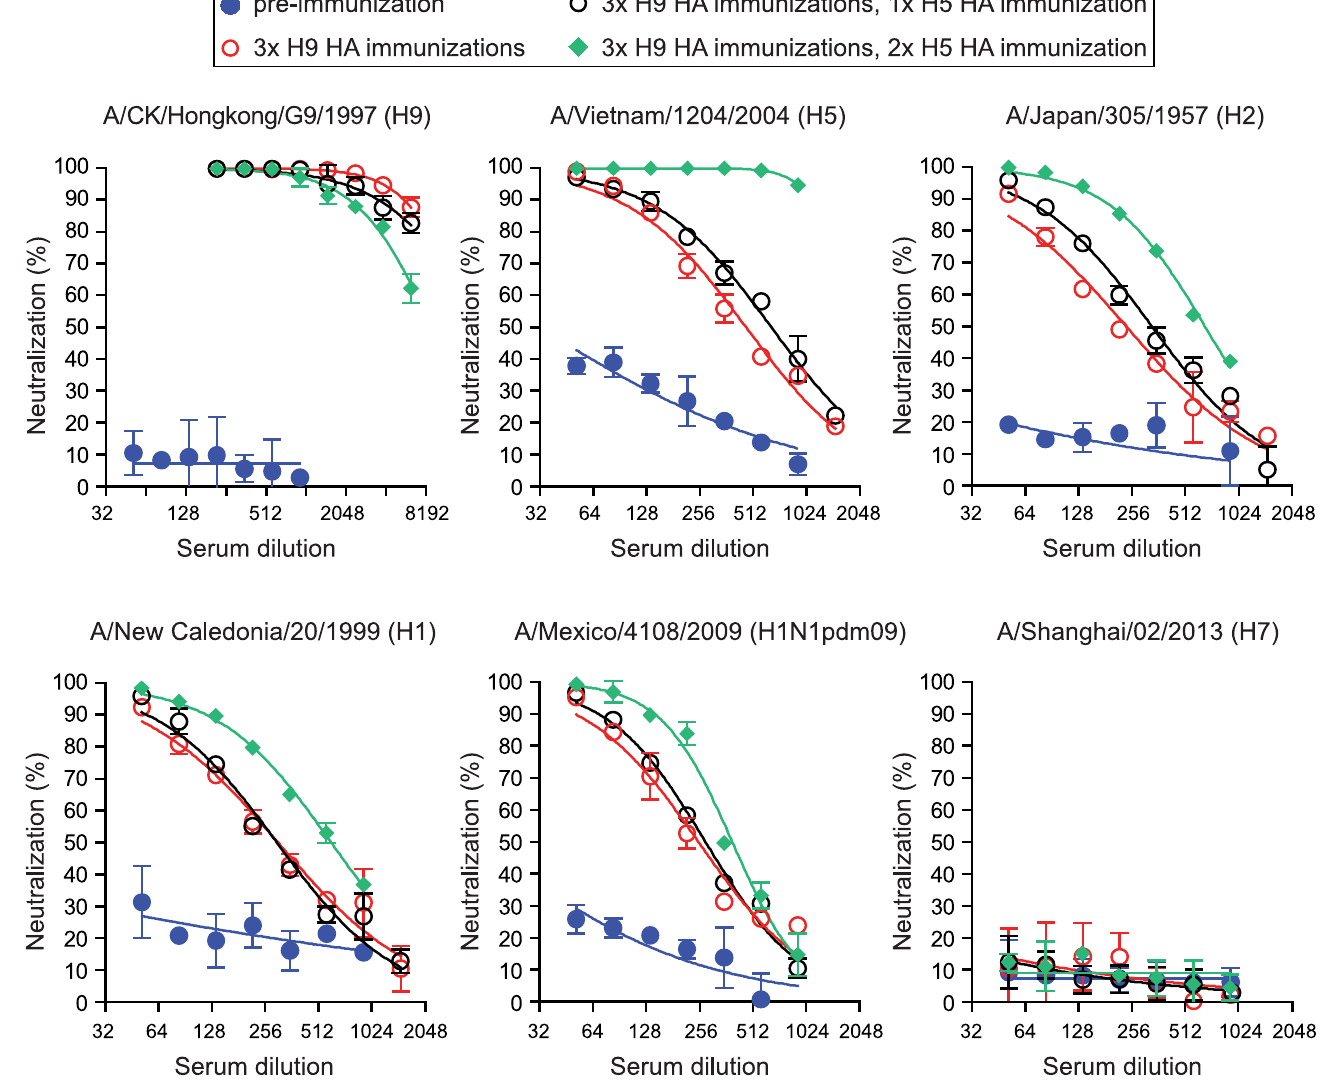
Fig 1. Heterosubtypic HA immunizations elicit cross-neutralizing antibodies. Neutralization ability against A/chicken/Hong Kong/G9/1997 (H9), A/Vietnam/ 1203/2004 (H5), A/Japan/305/1957 (H2), A/New Caledonia/20/1999 (H1), A/Mexico/4108/2009 (H1N1pdm09) and A/Netherland/219/2003 (H7) HA- pseudoviruses in one rabbit sera collected pre- and post- immunizations as indicated. Data are shown as means and standard deviations. Blue circle: pre- immunization; Red open circle: post 3 immunizations of H9 HA; Black open circle: post 3 immunizations of H9 HA and one immunization of H5 HA; Green diamond: post 3 immunizations of H9 HA and two immunizations of H5 HA. Similar results were obtained in other rabbit immunizations.